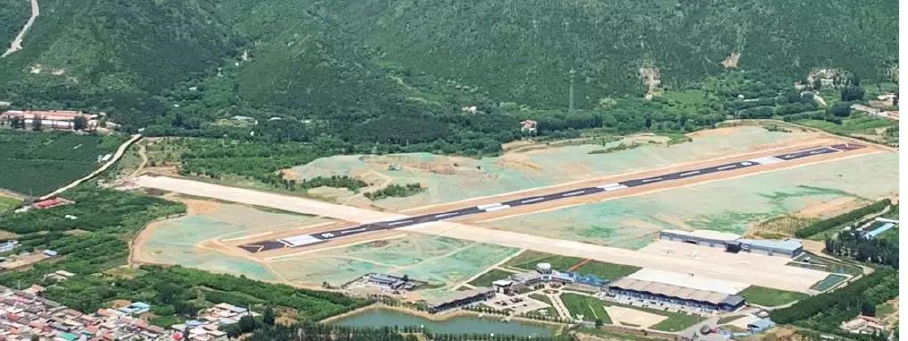
Figure 5. Photo of Beijing Miyun